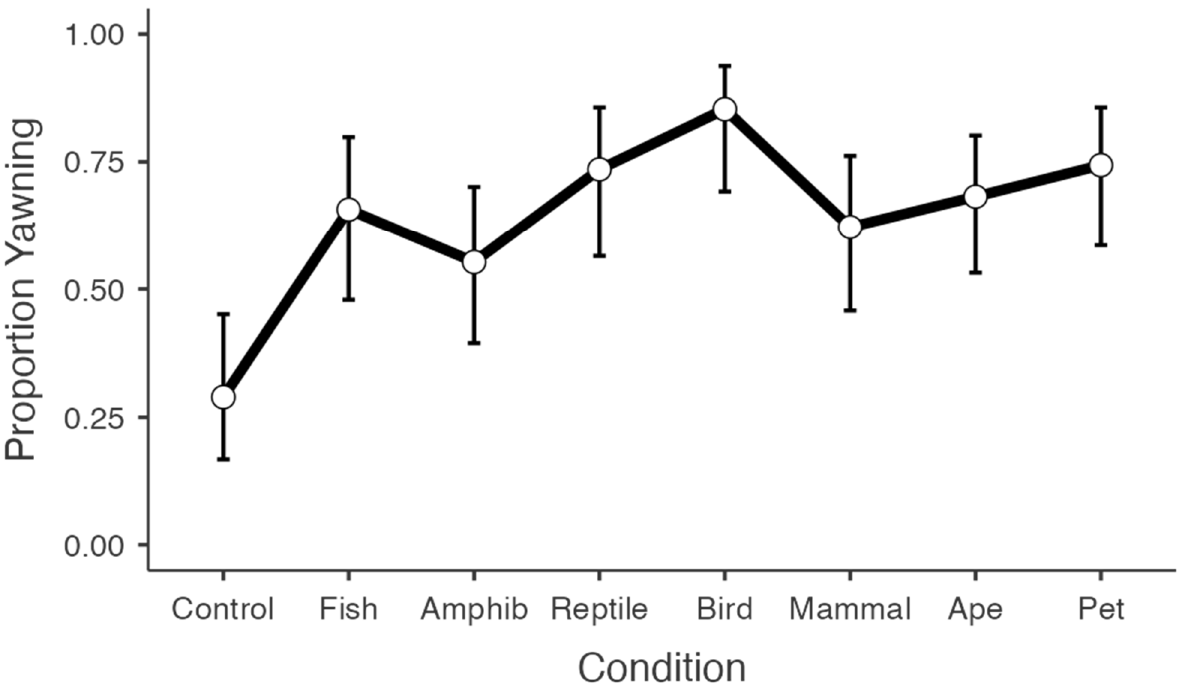
Figure 1. Line graph depicting the proportion of yawners and non-yawners across conditions. Note: data are presented as M ± 95% CI. For the yawn frequency model, stimulus condition and the tiredness of participants were again both significant predictors (Table 3). Participants across the interspecific yawn- ing conditions, with the exception of the amphibian and mammal conditions, reported a greater number of yawns compared to the control condition (Figure 2). Again, post